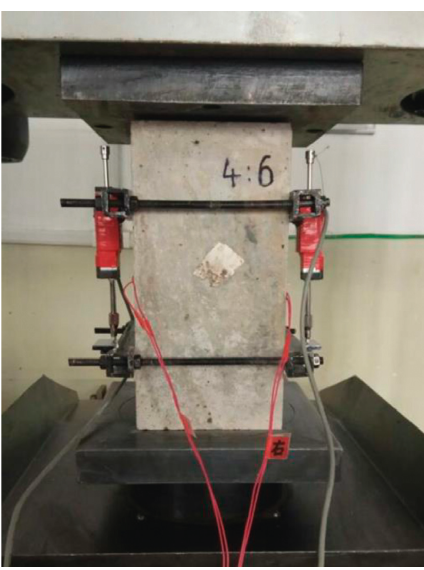
Figure 2: Mechanical experiment of the concrete prism. Table 1: Gradation of aggregates for concrete prism samples. Sieving size